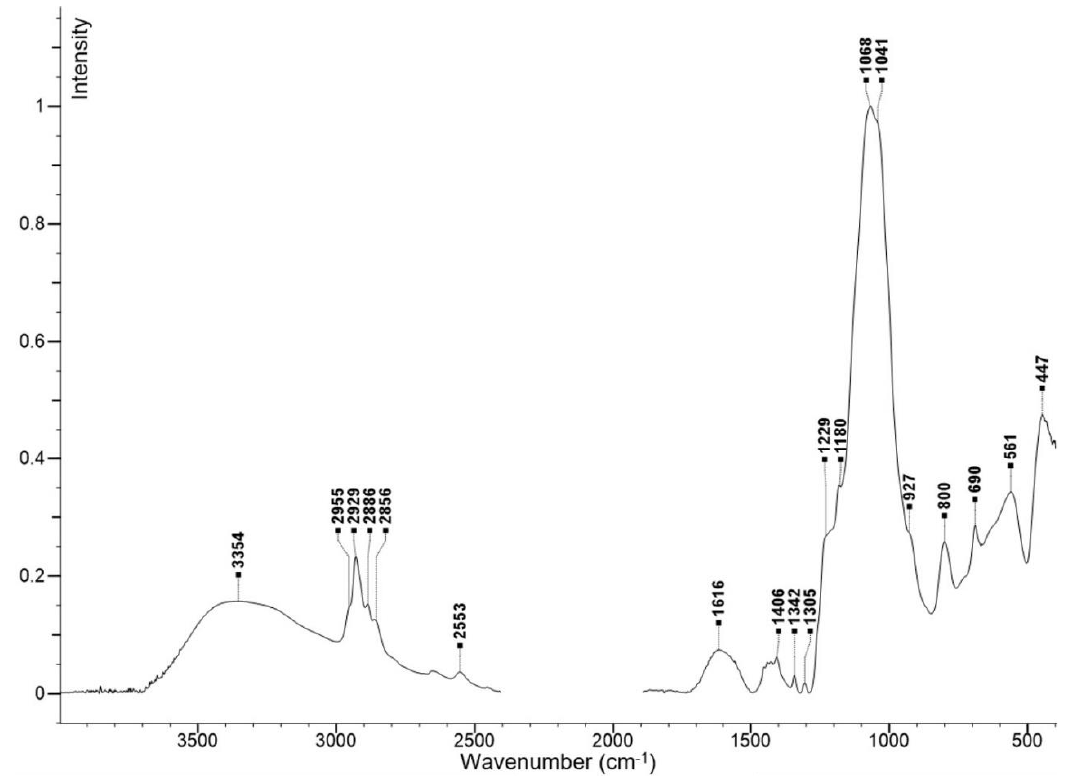
Figure 2. FT-IR spectra of prepared Fe 3 O 4 @SiO 2 -SH nanoparticles.